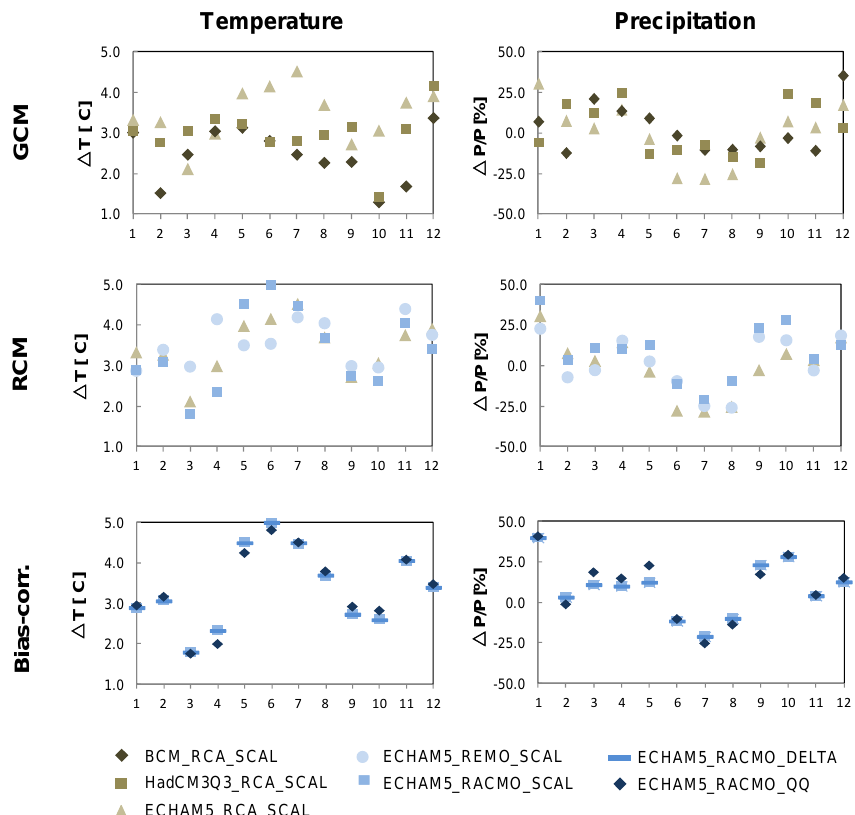
Fig. 6. Mean monthly changes in temperature ( T ) and precipitation ( P ) between the reference period (1971–2000) and the future scenario (2070–2099). Uncertainty originating from GCM, RCM and bias-correction is illustrated. Temperature and precipitation data are averaged across the catchment.